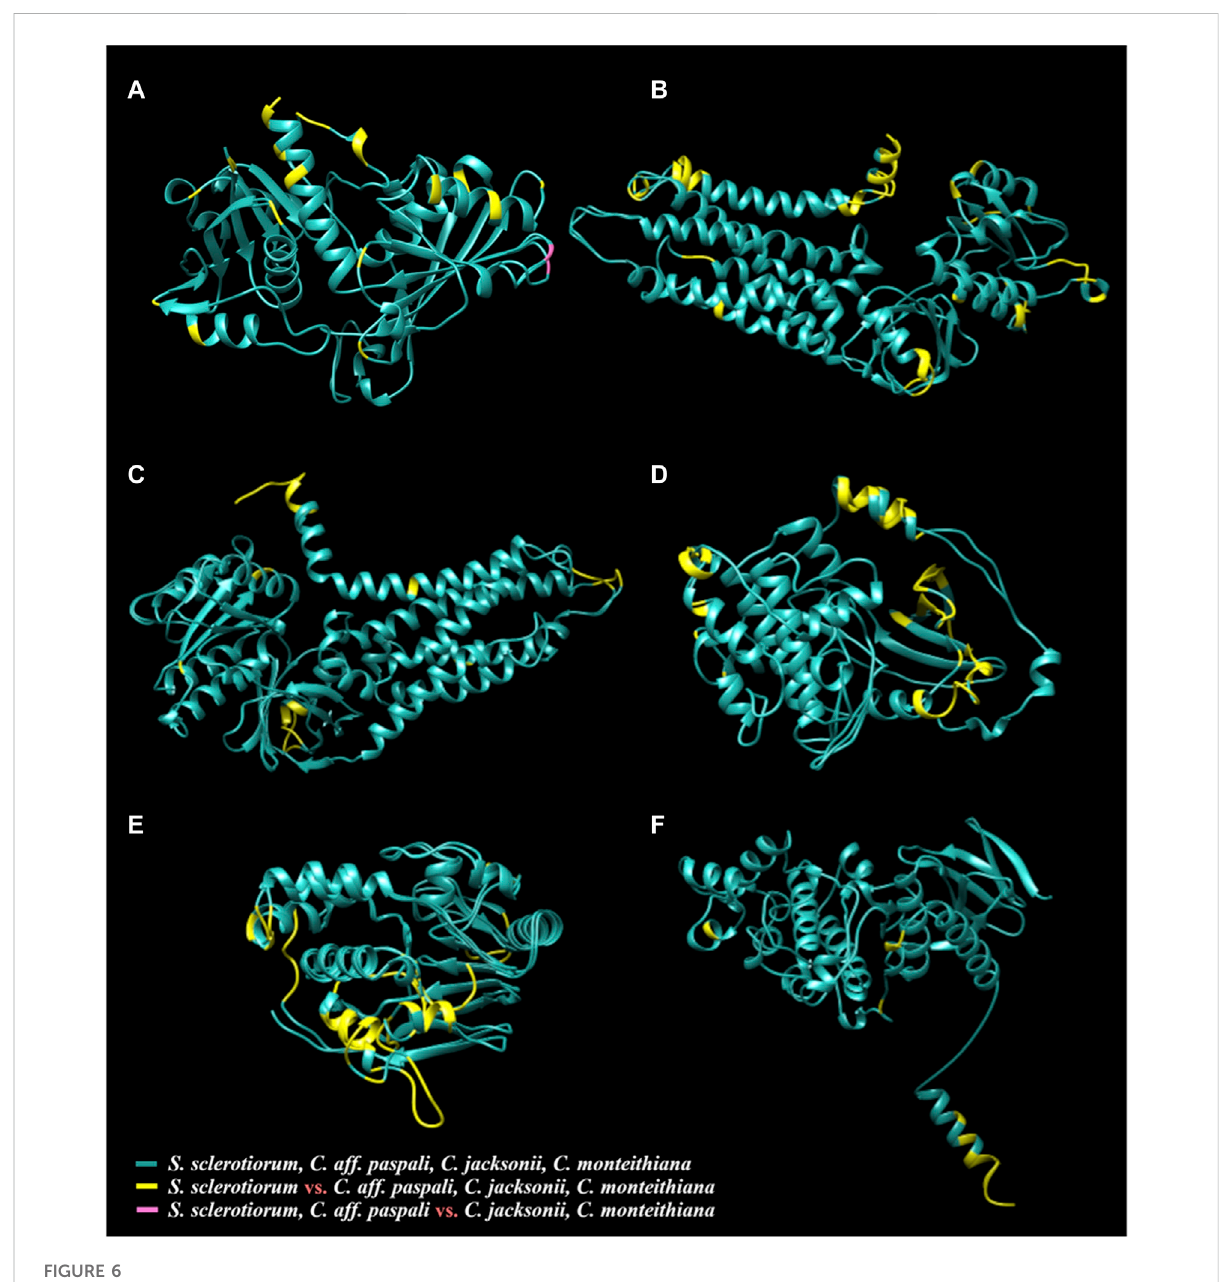
FIGURE 6 Three-dimensional protein models of six virulence genes [ (A) gpd , (B) nox1 , (C) nox2 , (D) pka1 , (E) pph1 , and (F) smk3 ] from S. sclerotiorum aligned with the respective protein structures from C. jacksonii , C. monteithiana , and C. aff. paspali . The common structures between all species are in green. The species-speci fi c structures of S. sclerotiorum that are distinct from all Clarireedia ( C. jacksonii , C. monteithiana and C . aff. paspali ) are highlighted in yellow. The single region in GPD (A) protein differentiating C . aff. paspli from C. jacksonii and C. monteithiana is color-coded in